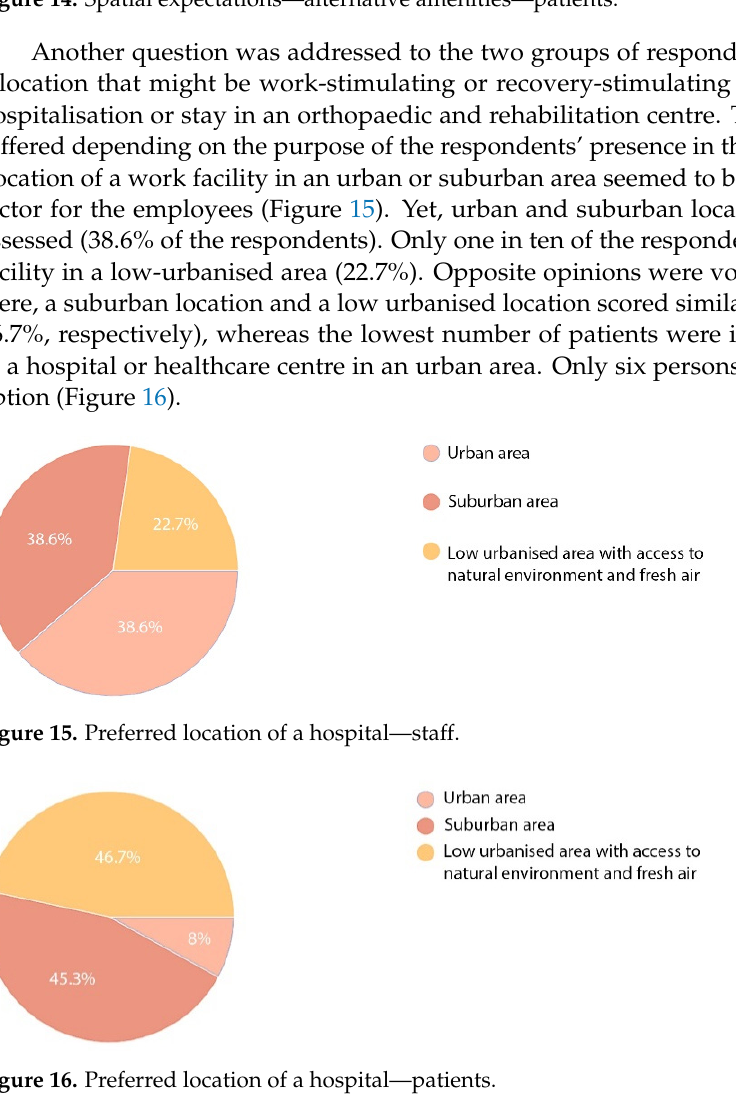
Figure 14. Spatial expectations—alternative amenities—patients .